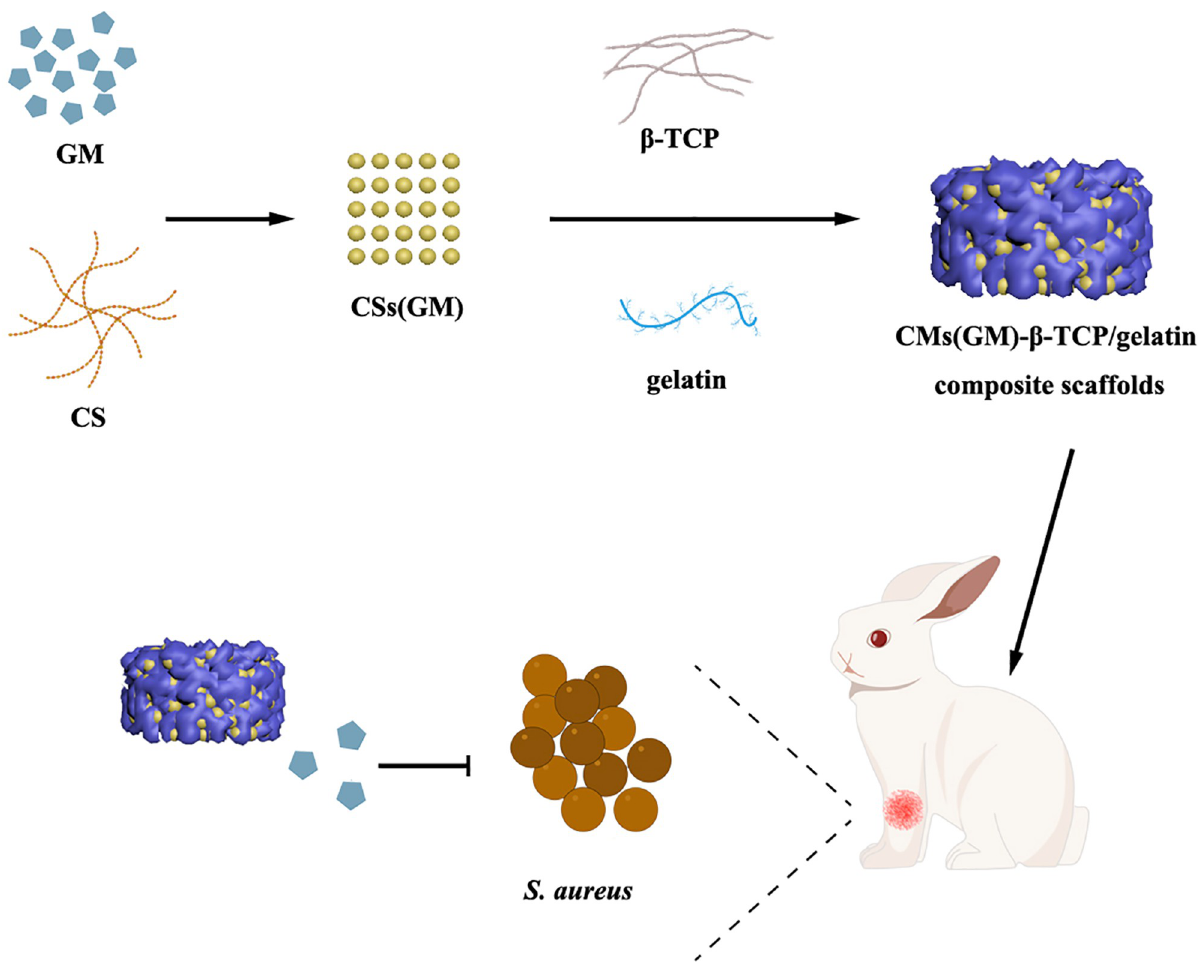
Fig 1. Preparation and mechanism of CMs(GM)- β -TCP/gelatin composite scaffolds (CMs: Chitosan microspheres; GM: Gentamycin; β -TCP: β - tricalcium phosphate; CS: Chitosan; S . aureus : Staphylococcus aureus